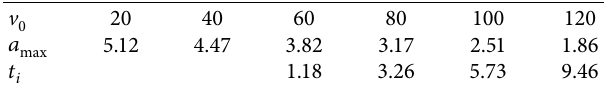
Table 2: Results of the braking acceleration and reaction delay time under low